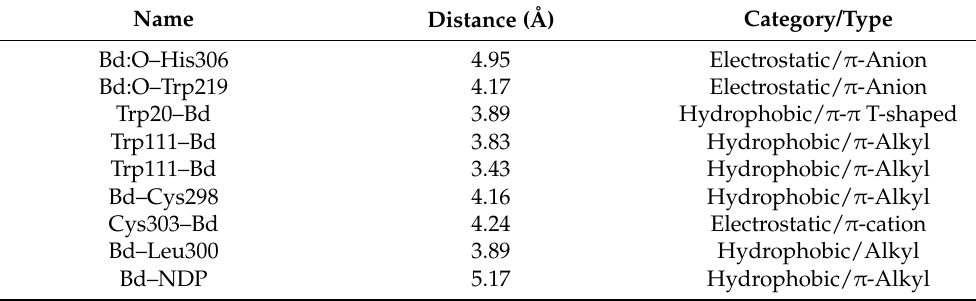
Table 7. Interactions between the deprotonated Bd (C17C15C2-COOH) and the receptor pocket. Complex established by our method (founded on shape